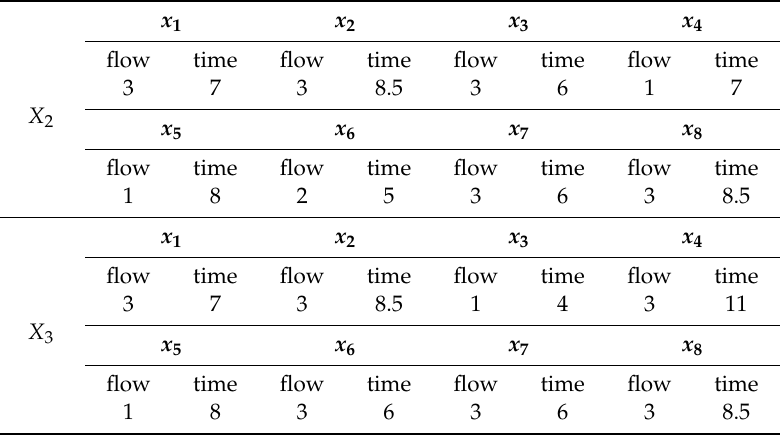
Table 26. Transport time and flow for each arc.